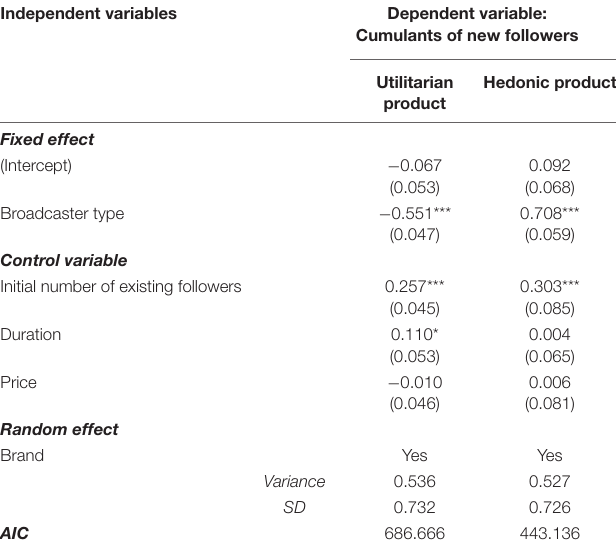
TABLE 4 | Results from moderation analyses. Independent variables Dependent variable: Cumulants of new